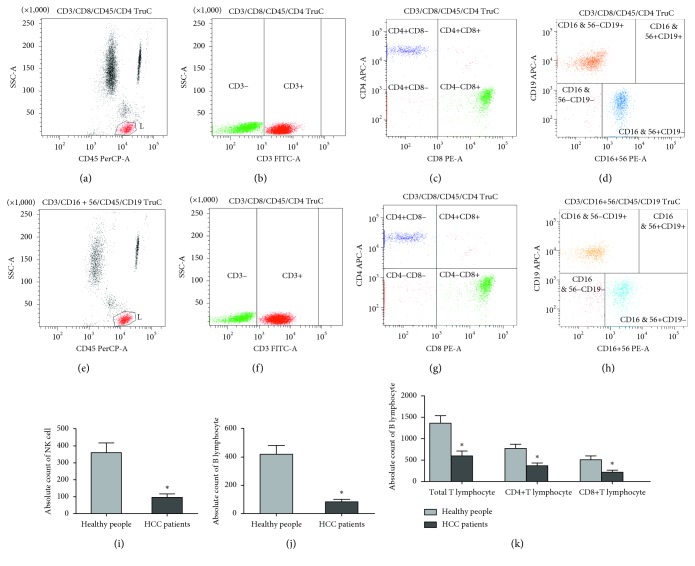
Assessment lymphocyte subset by FCM from 20 patients with HCC and 20 healthy individuals. (a, e) Identification of total lymphocyte (CD45+) cell count in healthy individual and HCC patient blood. (b, f) Identification of total T lymphocyte (CD3+) cell count in healthy individuals' and HCC patients' blood. (c, g) Different expression of CD4+ T lymphocyte (CD4+ CD8−) and CD8+ T lymphocyte (CD4− CD8+) in healthy individuals' and HCC patients' blood, respectively. (d, h) Identification of B lymphocyte (CD16 & 56− CD19+) cell count and NK cell count (CD16 & 56+ CD19−) in healthy individuals' and HCC patients' blood, respectively. (i) Absolute count of NK cell in healthy individuals' and HCC patients' blood, respectively. (j) Absolute count of B lymphocyte in healthy individuals' and HCC patients' blood, respectively. (k) Absolute count of various T lymphocyte in healthy individuals' and HCC patients' blood. (∗Differences between the groups were significant (P < 0.05)).